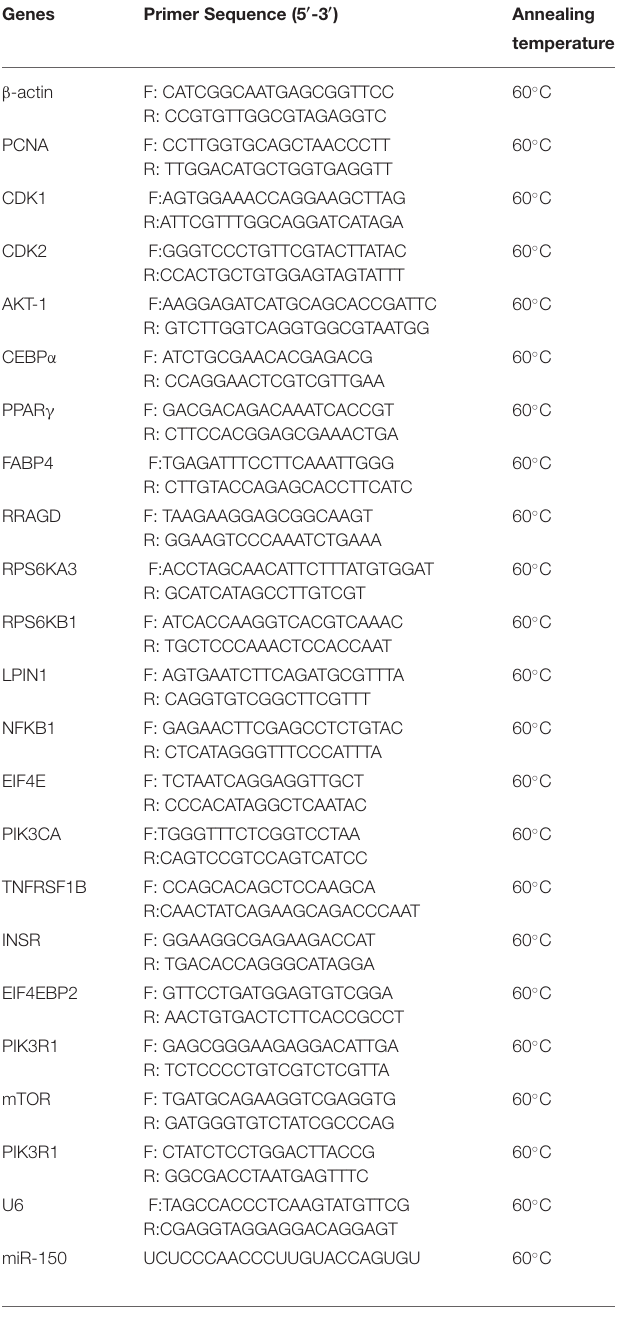
TABLE 2 | mRNA and miRNA Real-time quantitative PCR primer sequences. Genes Primer Sequence (5 ′ -3 ′ )